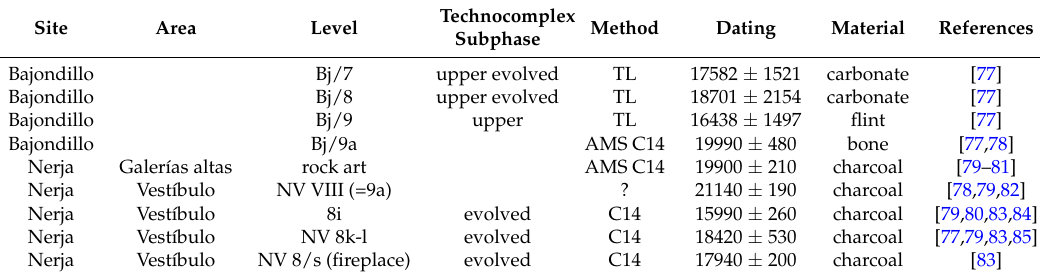
Table 2. Solutrean dating from Bajondillo and Nerja. Bj: Bajondillo NV: Nerja Vestíbulo area, TL: Thermoluminescence dating, AMS C14: Accelerator mass spectrometry radiocarbon dating, C14: Radiocarbon dating.